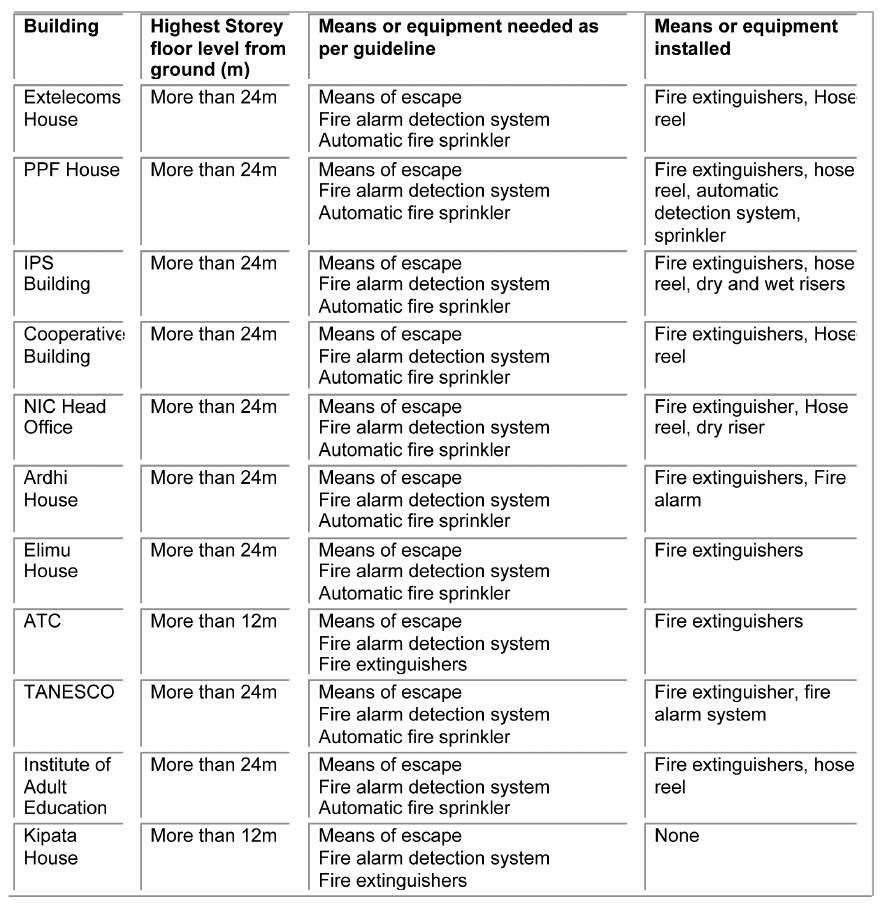
Table 3. Available facilities and means versus the